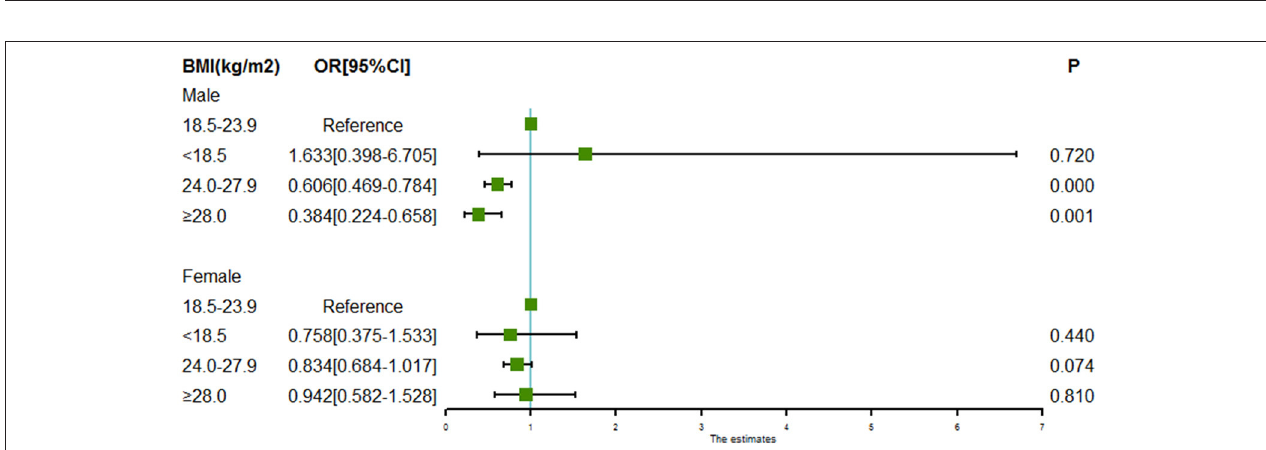
FIGURE 1 | Forest plot of ORs for the association between BMI and intracranial aneurysm rupture. Compared to the patients with normal BMI (18.5 to < 24.0 kg/m 2 ), odds of intracranial aneurysm rupture were significantly lower in the patients with BMI 24.0 to < 28.0 kg/m 2 and patients with BMI ≥ 28.0 kg/m 2 . Low BMI ( < 18.0 kg/m 2 ) was not associated with intracranial aneurysm rupture. Taking the patients with BMI < 24 kg/m 2 as a reference, the patients with BMI ≥ 24.0 kg/m 2 had a lower odds of intracranial aneurysm rupture as well.